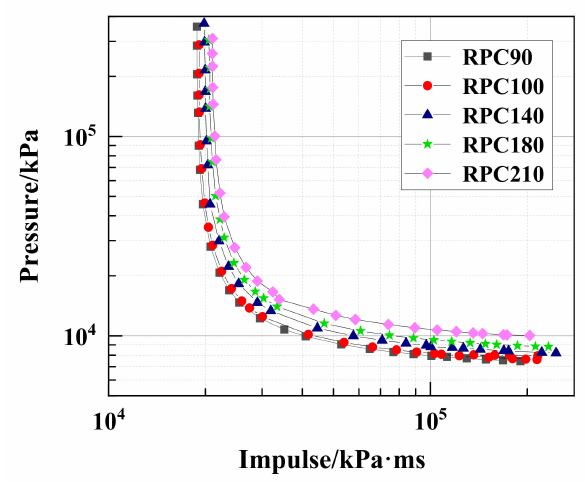
Figure 19. P-I curves of shear damage to different RPC strength. Table 11. Effects of RPC strength on